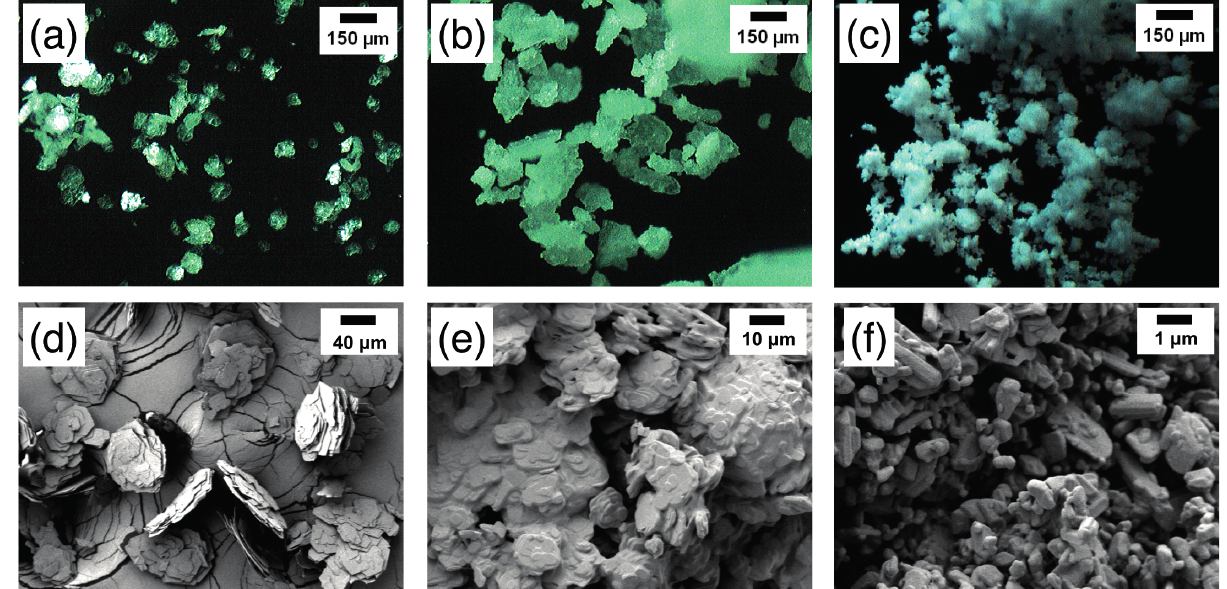
Figure 2. Optical micrographs of AD (a) , AD/GLU (b) , and AD/SUB (c) ; scanning electron micrographs of AD (d) , AD/GLU (e) , and AD/SUB (f)